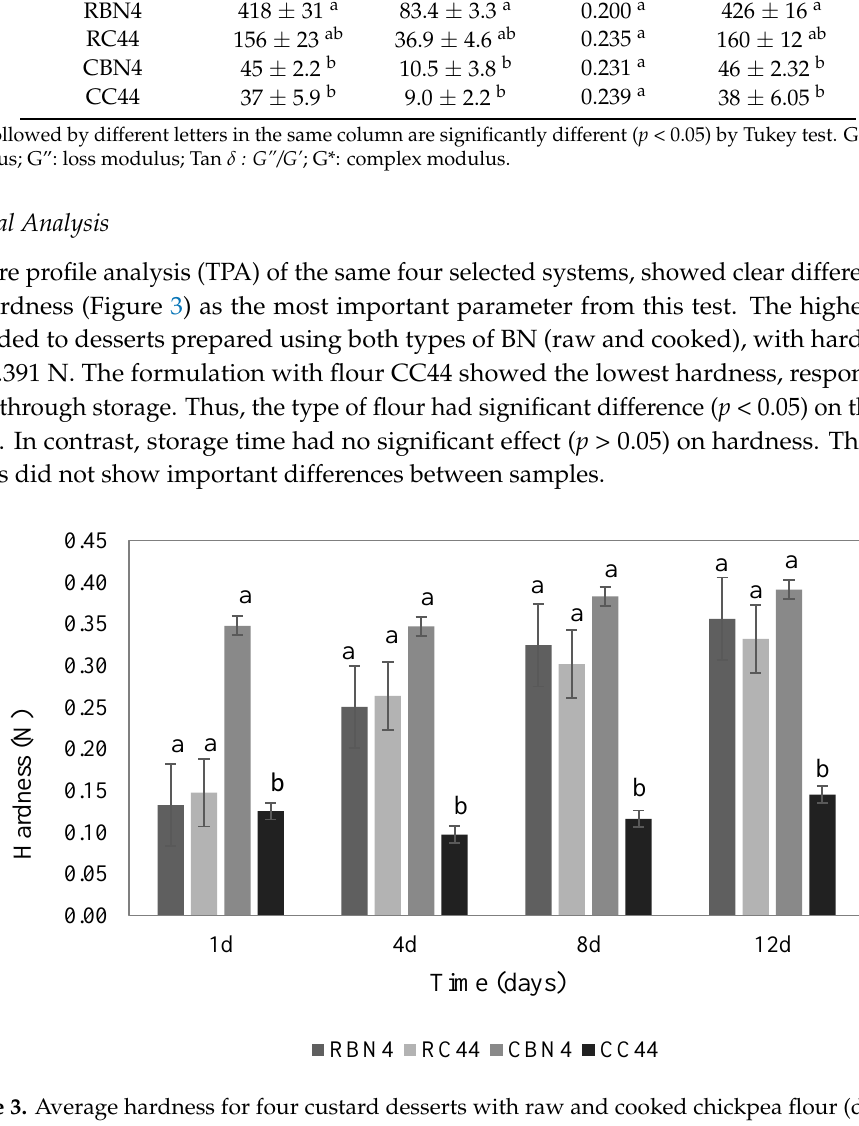
Figure 3. Average hardness for four custard desserts with raw and cooked chickpea flour (different letters indicating significant difference, p < 0.05 by Tukey test).